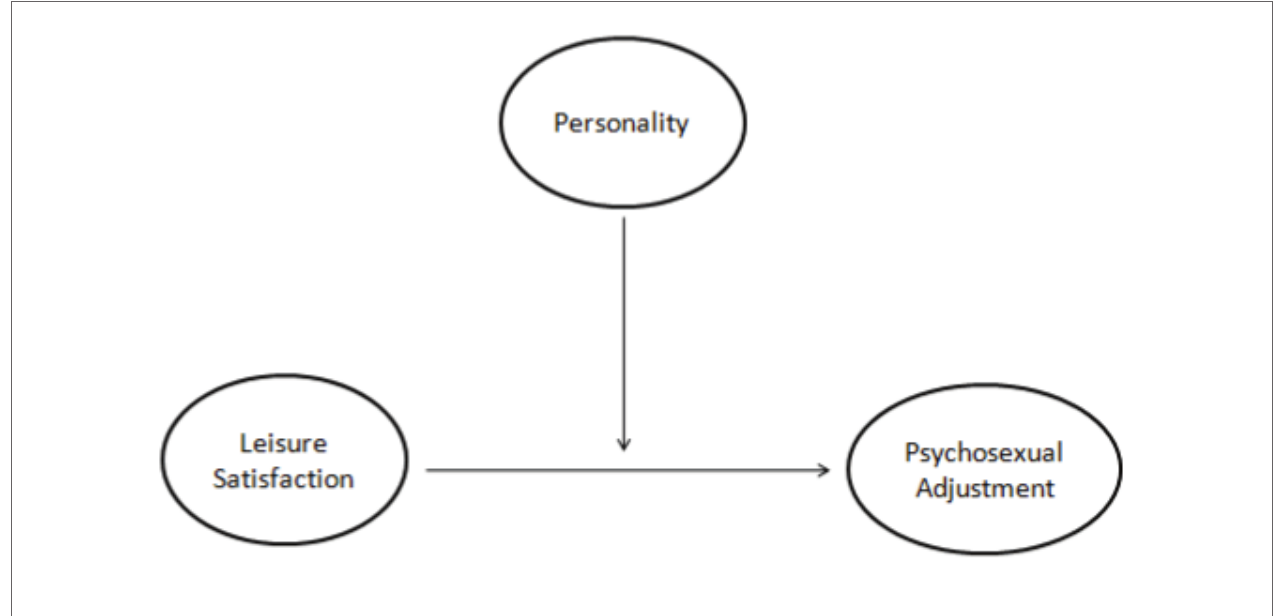
FIGURE 1 | The moderation model used in this